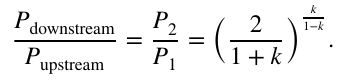
Fig. 1 Comparison of estimated oil well rate (Gilbert’s equation) with measured rate